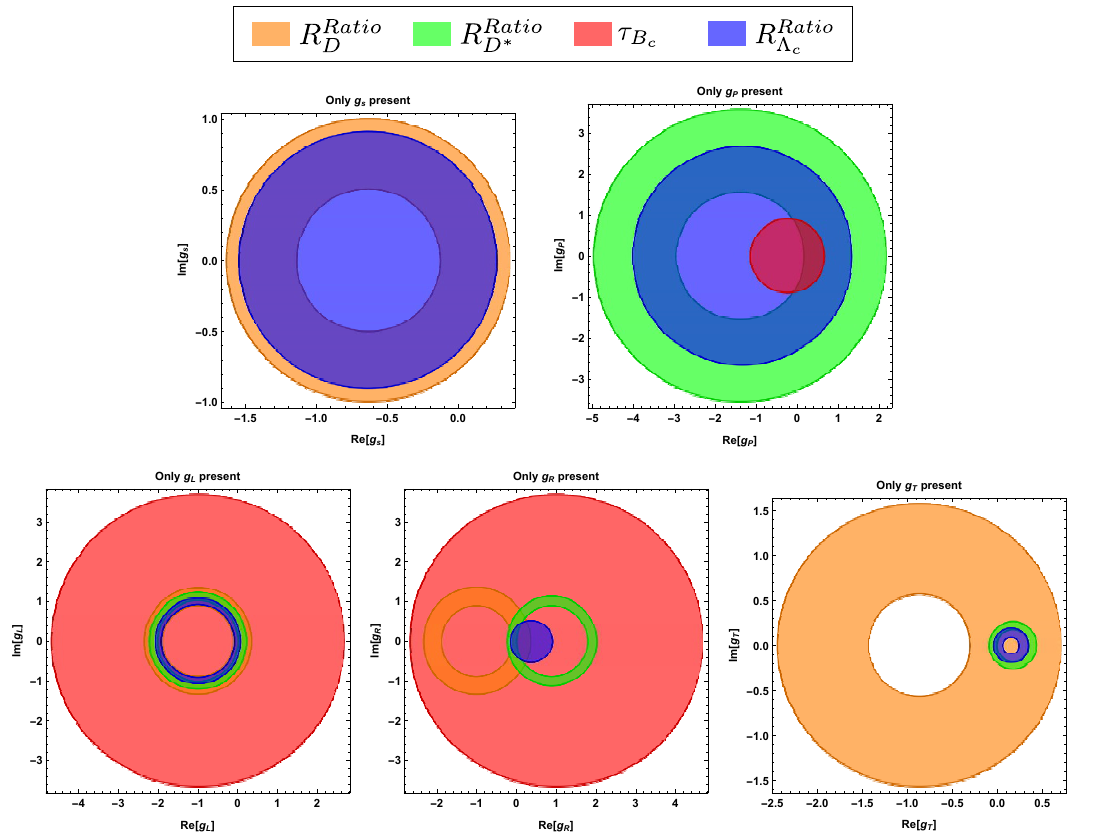
Figure 5 . Constraints on individual new-physics couplings from a possible R (Λ c ) measurement (shown in blue), assuming that R Ratio are the mesonic constraints as in figure